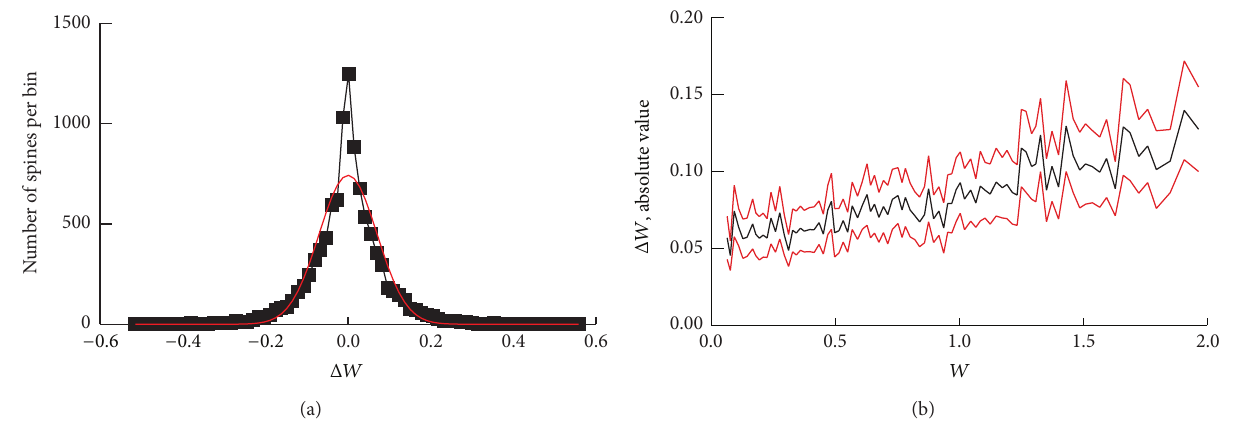
Figure 4: Distributions of the magnitude of synaptic weight change. (a) Black trace, histogram with 80 bins illustrating the steady-state distribution of weight update amplitudes for the active synapses in Figure 2(a). These amplitudes consist of all the synchronous weight updates for the 9,482 active synapses (out of 10,000 total), at a given time step. Red curve, a normal distribution (mean 0.0, standard deviation 0.07) that approximates the histogram excepting the sharp peak for update amplitudes near zero. (b) A histogram of Δ𝑊 versus 𝑊 shows a slightly increasing, relatively linear trend. 80 bins for 𝑊 are equally spaced on a log scale. Black trace, mean values of Δ𝑊 . Red traces, mean ± 1 standard